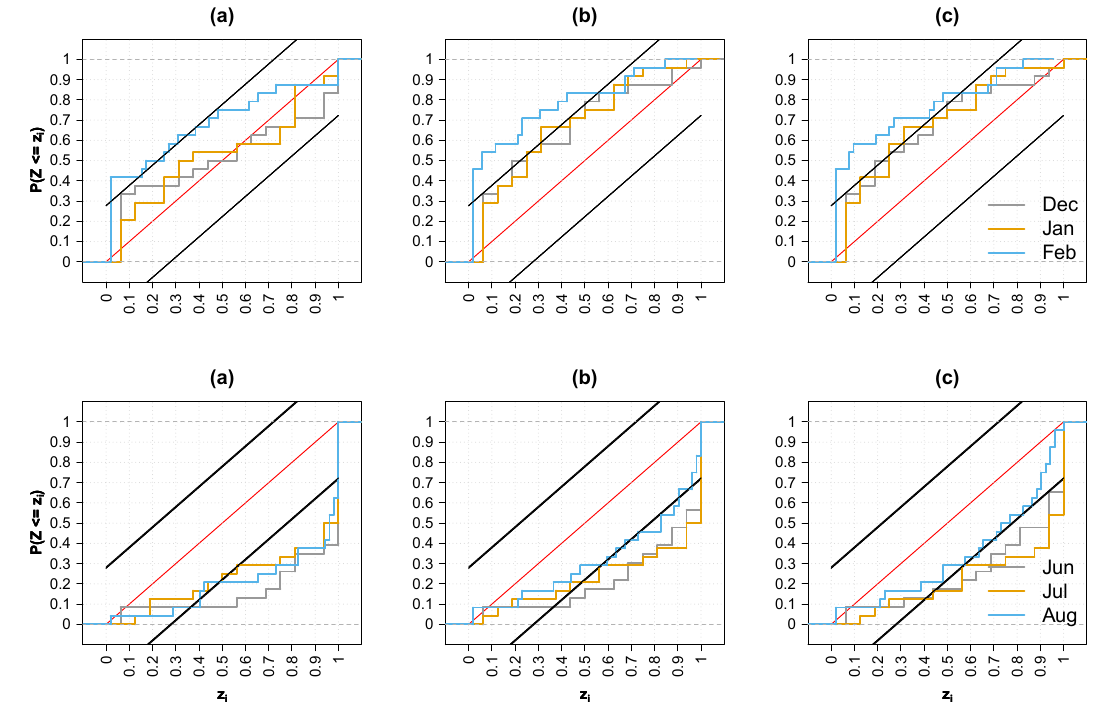
Figure 6. PIT diagrams of monthly means of daily streamflow forecasts for winter (upper row) and summer (bottom row) of station 82 for (a) raw meteorological forecasts and preprocessed meteorological forecasts with (b) linear scaling/delta change (LS) and (c) quantile mapping (QM). The lead time is 1 month. Different colors represent different months in the season. The black lines parallel to the 1:1 diagonal are the Kolmogorov bands at the 5% significance